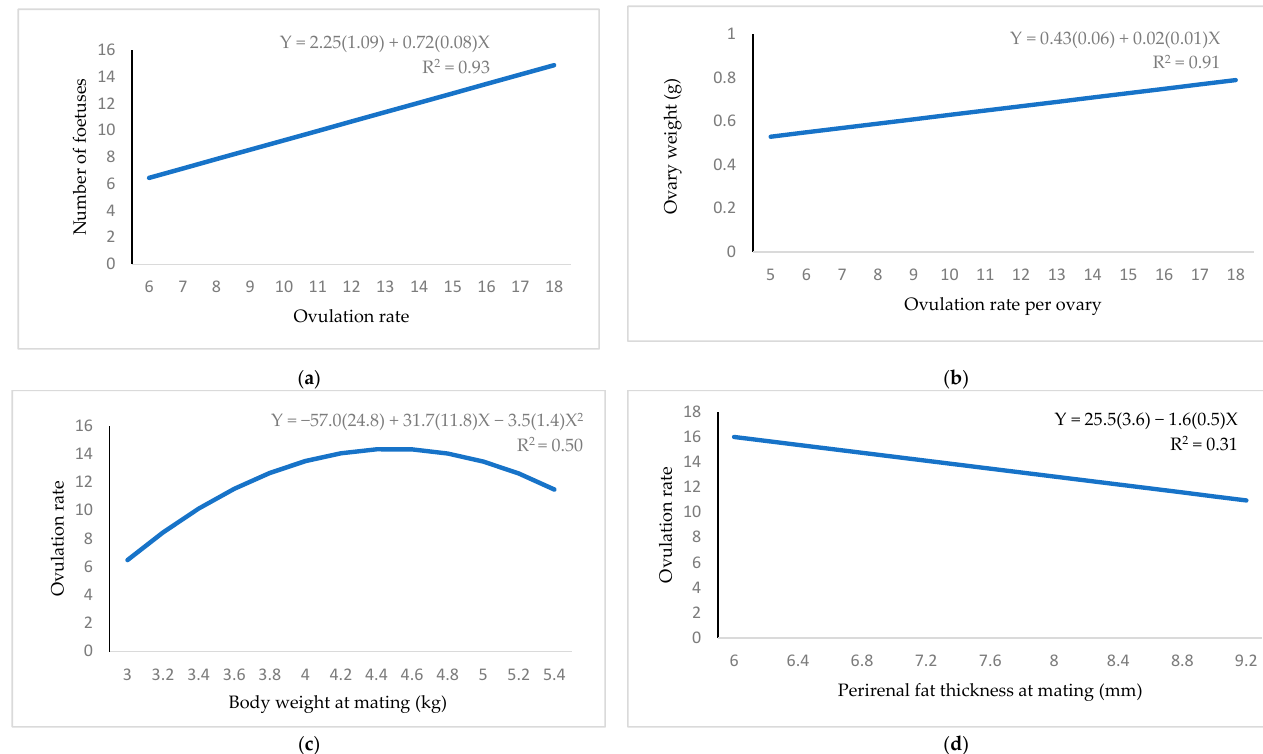
Figure 1. Regression equation (standard error between brackets) at mating for the relationship between: ( a ) ovulation rate and number of foetuses; ( b ) ovulation rate per ovary and its ovary weight; ( c ) body weight and ovulation rate; ( d ) perirenal fat thickness and ovulation rate.